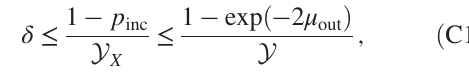
FIG. 9. Asymptotic key rate state efficient BB84 protocol, under a passive THA. The rate is plotted for various values of the parameter μ simulation are as in Fig.